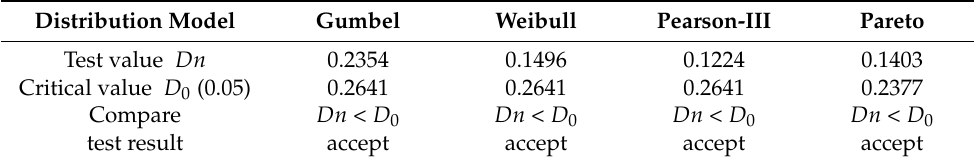
Table 2. K-S test of the distribution model of increasing water series ( ∆ t = 12).